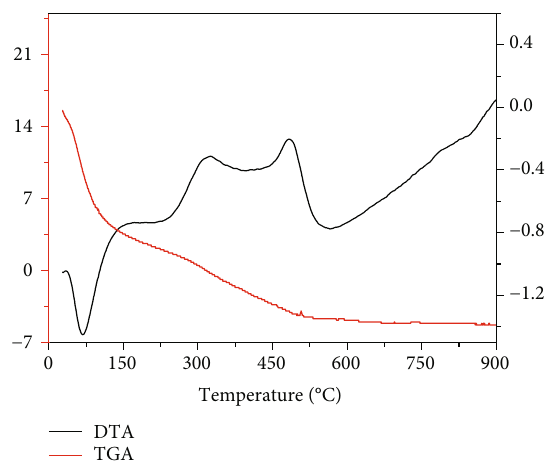
Figure 5: Thermal analysis results for the uncalcined TiO NPs.